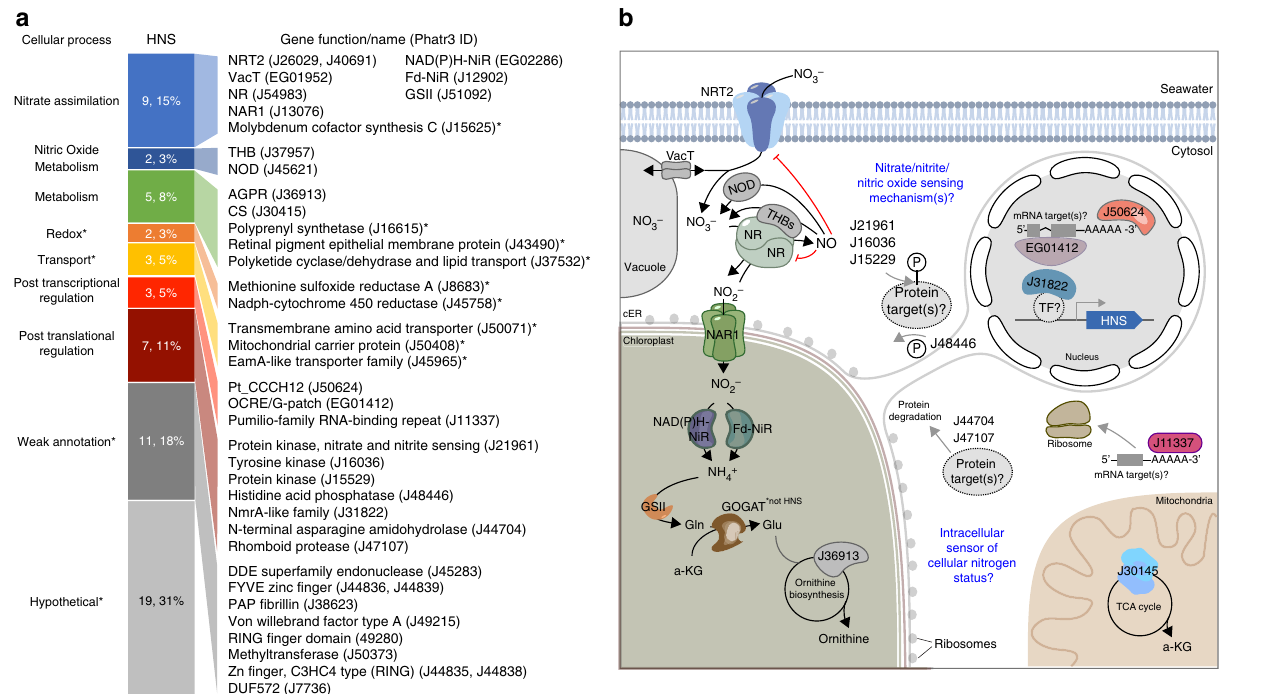
Fig. 2 Functional annotations of highly nitrate-sensitive (HNS) gene set and model of nitrate assimilation and regulatory components in Phaeodactylum tricornutum . a Cellular processes and associated annotation descriptions of the HNS; numbers indicate total genes belonging to each process and percentage of the HNS that process comprises. When possible, the gene name is indicated, otherwise, pFAM descriptions are shown. Full annotations are available in Supplementary Data 3. Phatr3 model IDs are shown for each gene. Asterisk (*) = gene or process is not depicted in b . b Scheme (after Sanz- Luque et al. 3 ) of nitrate assimilation pathway showing HNS genes with putative roles in nitric oxide metabolism (THB, NOD) and posttranscriptional and posttranslational regulation of unknown mRNA and protein targets. The HNS genes of the ornithine biosynthesis pathway and TCA cycle are also depicted. cER chloroplast endoplasmic